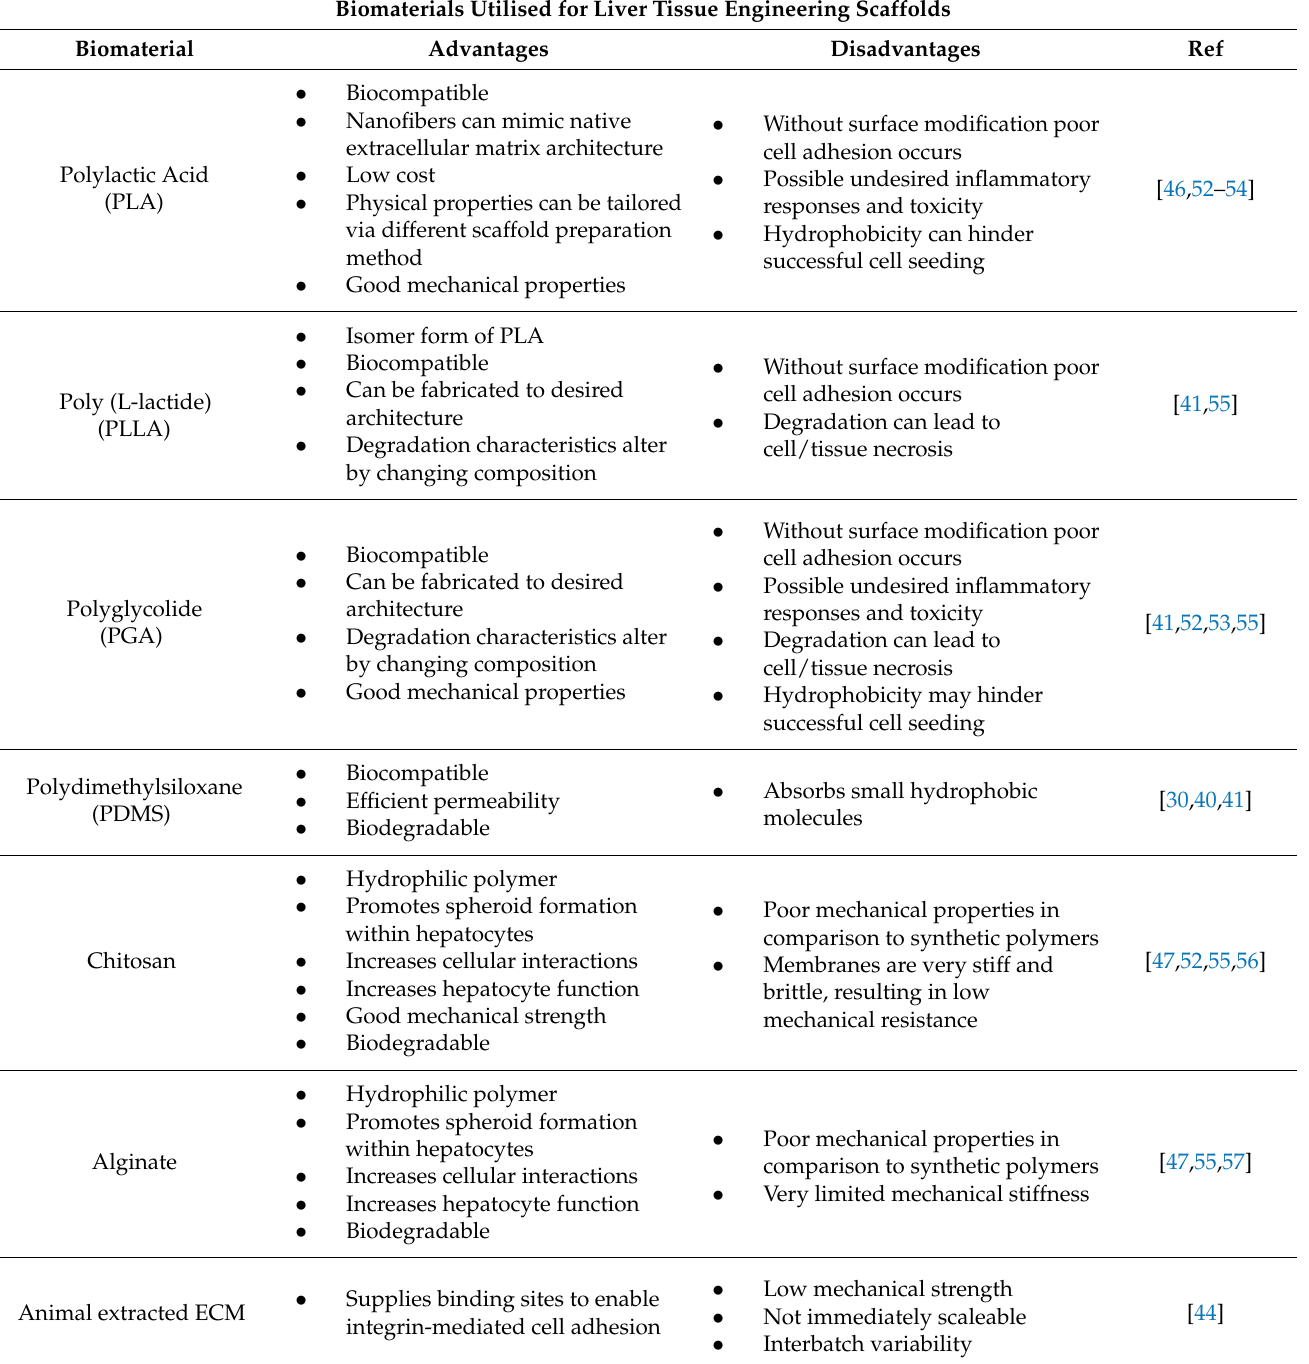
Table 1. Summary of biomaterials used for scaffolds in liver tissue engineering. Biomaterials Utilised for Liver Tissue Engineering Scaffolds